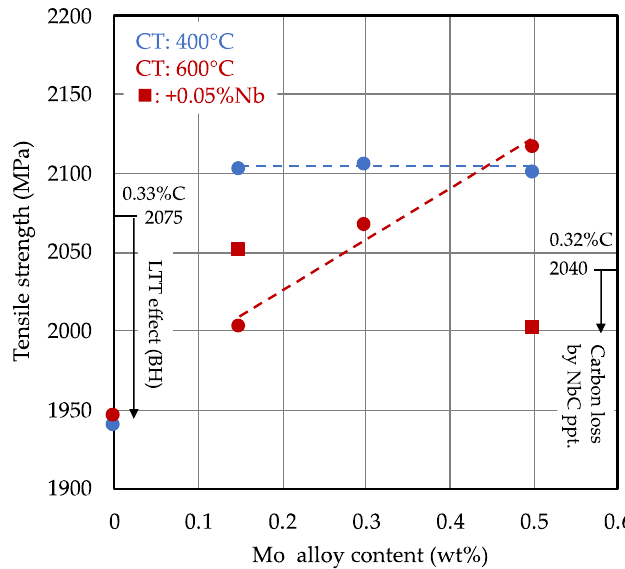
Figure 4. Effect of molybdenum and niobium alloy content on tensile strength after water quenching and bake hardening treatment (CT: coiling temperature; short heating cycle); as-quenched base strength is calculated according to [3], with permission from authors, 2018.